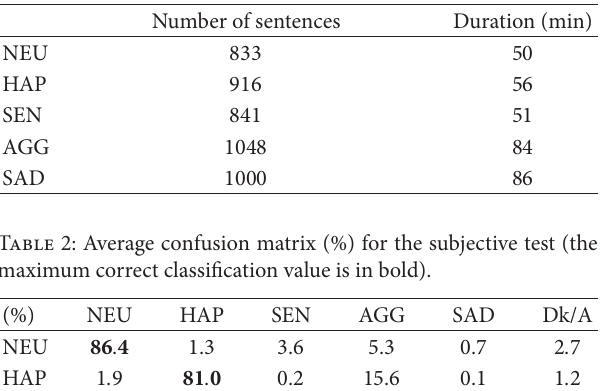
Table 1: Number of sentences and duration, per expressive speech style, for the expressive corpus.